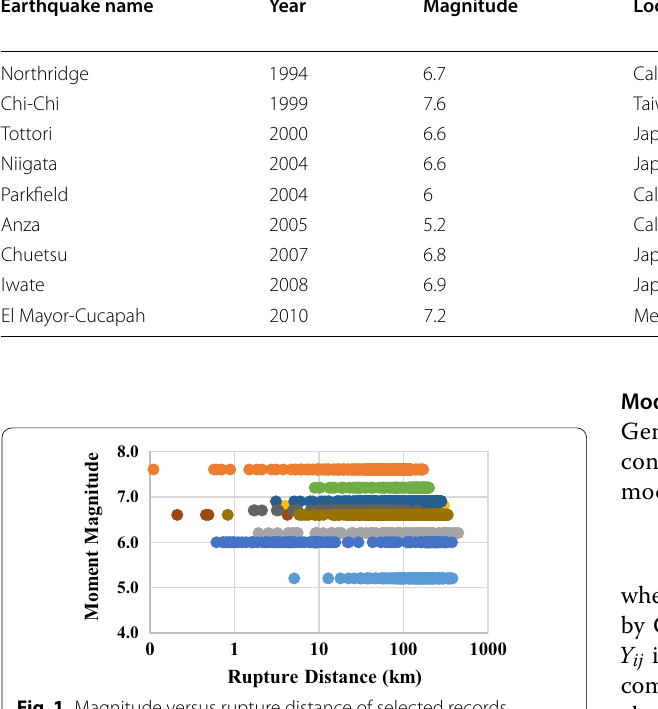
Table 1 List of earthquake events used in this study Earthquake name